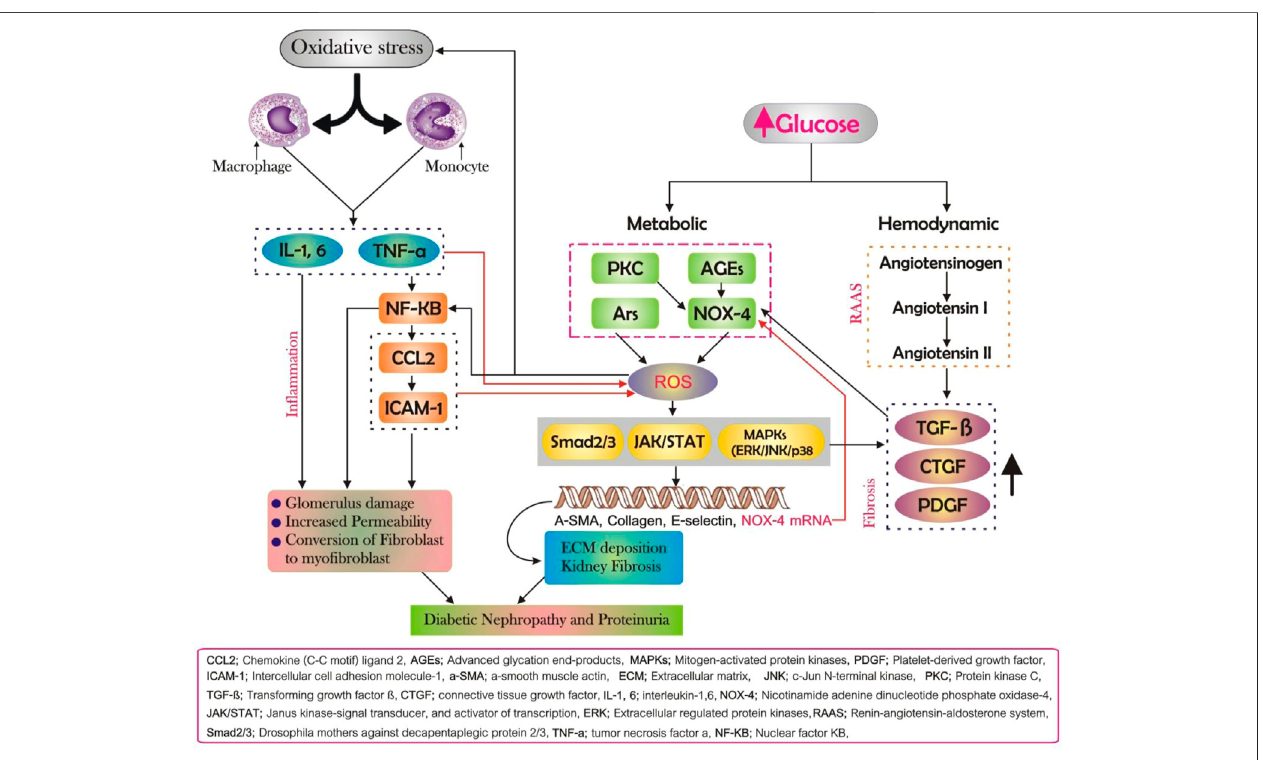
FIGURE2| Diabeticnephropathy(DN) ’ spathogenesis.Fibrosis,in fl ammation,andoxidativestressallhaveaninvolvementintheonsetandprogressionofDN,and each of these pathways is intricately linked and reinforcing each other. A major part of DN is oxidative stress, which triggers in fl ammation and fi brosis, both of which increase oxidative stress; renal fi brosis occurs as a result of in fl ammation, exacerbating the in fl ammatory response.